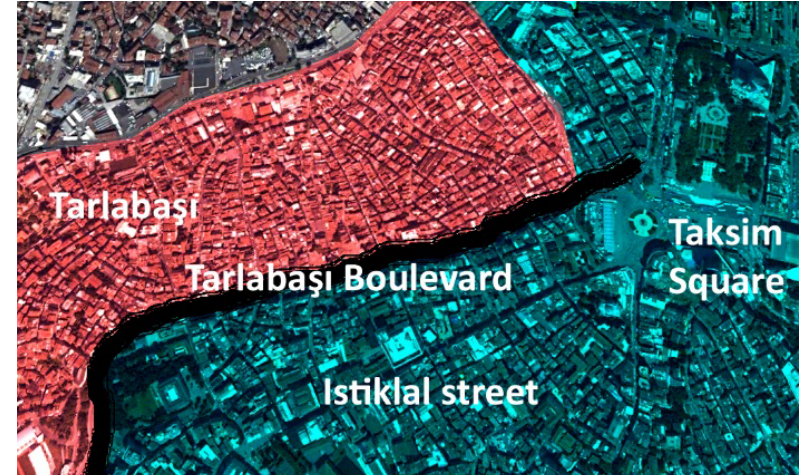
Figure 1. Tarlabaşı Boulevard separates the Tarlabaşı neighborhood from Taksim square and the Istiklal street area. Source: